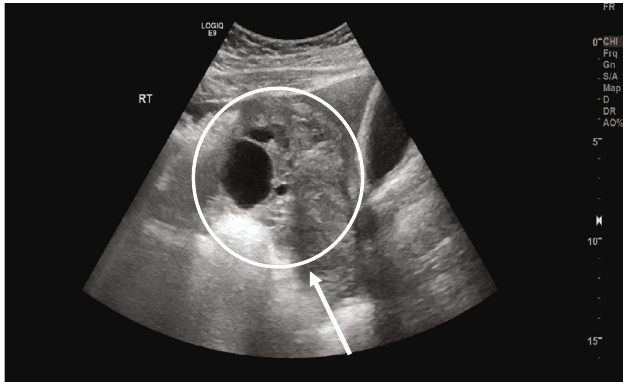
Figure 2: Pelvic sonography of the right ovary, visualizing an ectopic pregnancy.